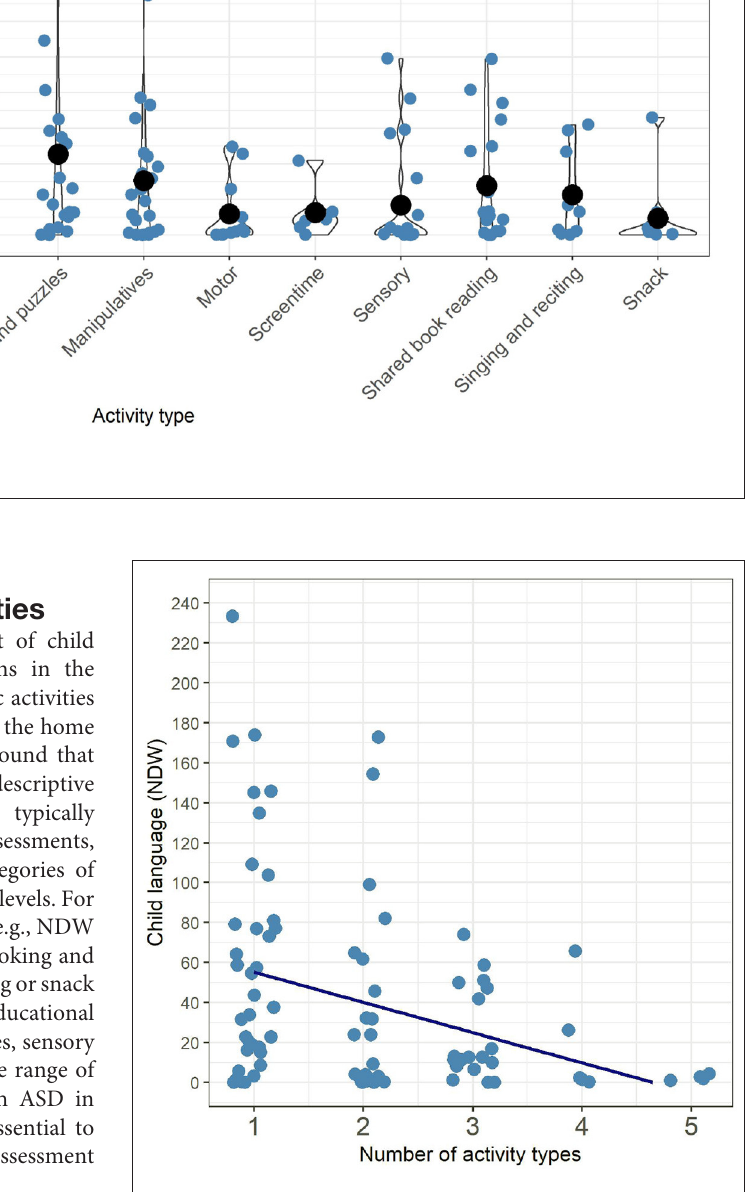
significant difference in child language level across